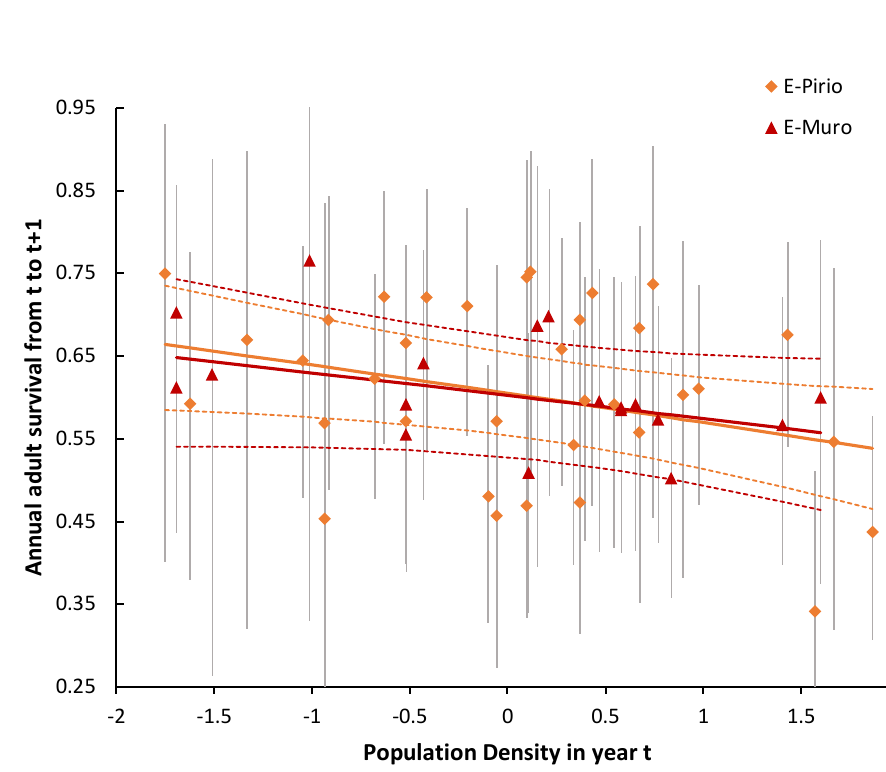
Figure 3 : Effect of population density in year t on annual adult survival from t to t+1, in 4 populations of blue tits. A: Population density across the years of monitoring in the different populations. B: Model selection in each population separately to test for an effect of population density on adult survival. C: Annual adult survival as a function of population density in E-Pirio (orange) and E-Muro (red). Single points represent yearly estimates from Models 85 and 91 (see B) with 95% confidence intervals, lines represent the adult survival – population density relation as estimated by Models 83 and 90 (see B) with 95% confidence intervals in dotted